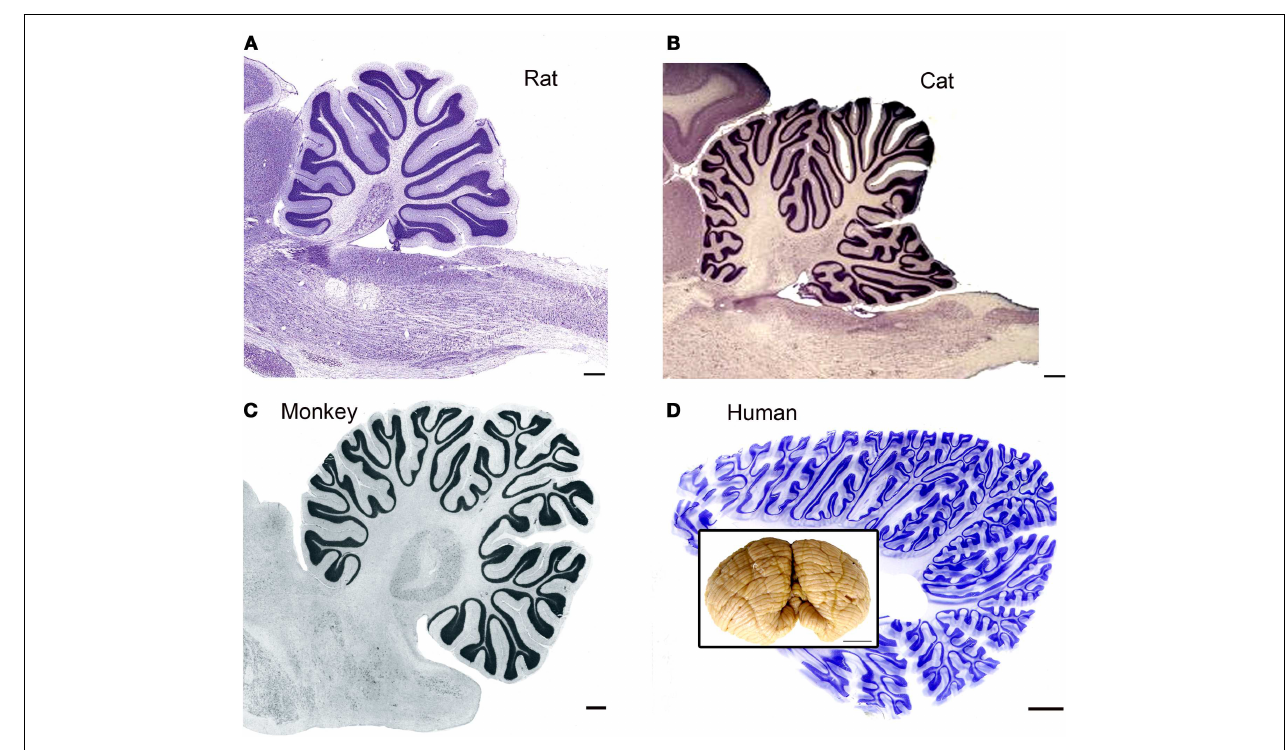
the dentate nucleus.The image is from Madigan and Carpenter (1971), Figure 25, p. 40. Scale bar 1mm. (D) Parasagittal section through the human cerebellum at a level lateral to the dentate nucleus. Scale bar 10mm.The inset shows a photograph of an intact human cerebellum, inferior view, Case 188 (Witelson Normal Brain Collection, female, age 67). Scale bar in inset